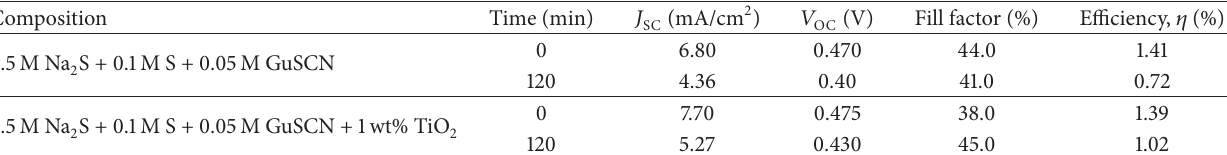
nanoparticles in the electrolyte. Electrolyte used: 0.5 M Na 2